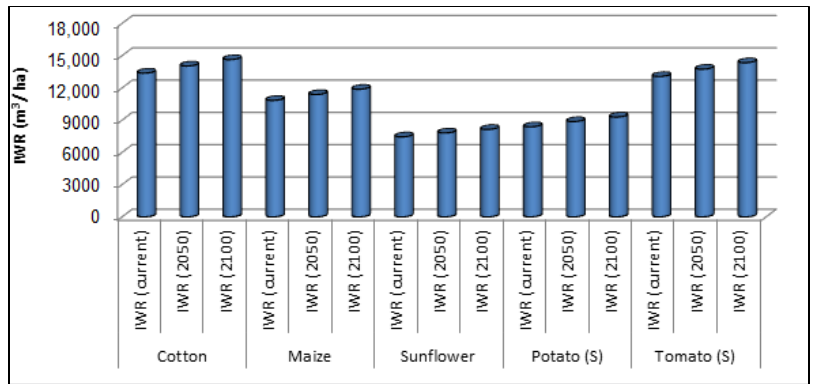
Figure 7. Average irrigation water requirements (IWR) for some main summer crops in Middle Egypt under current and climate change conditions over 30 years.